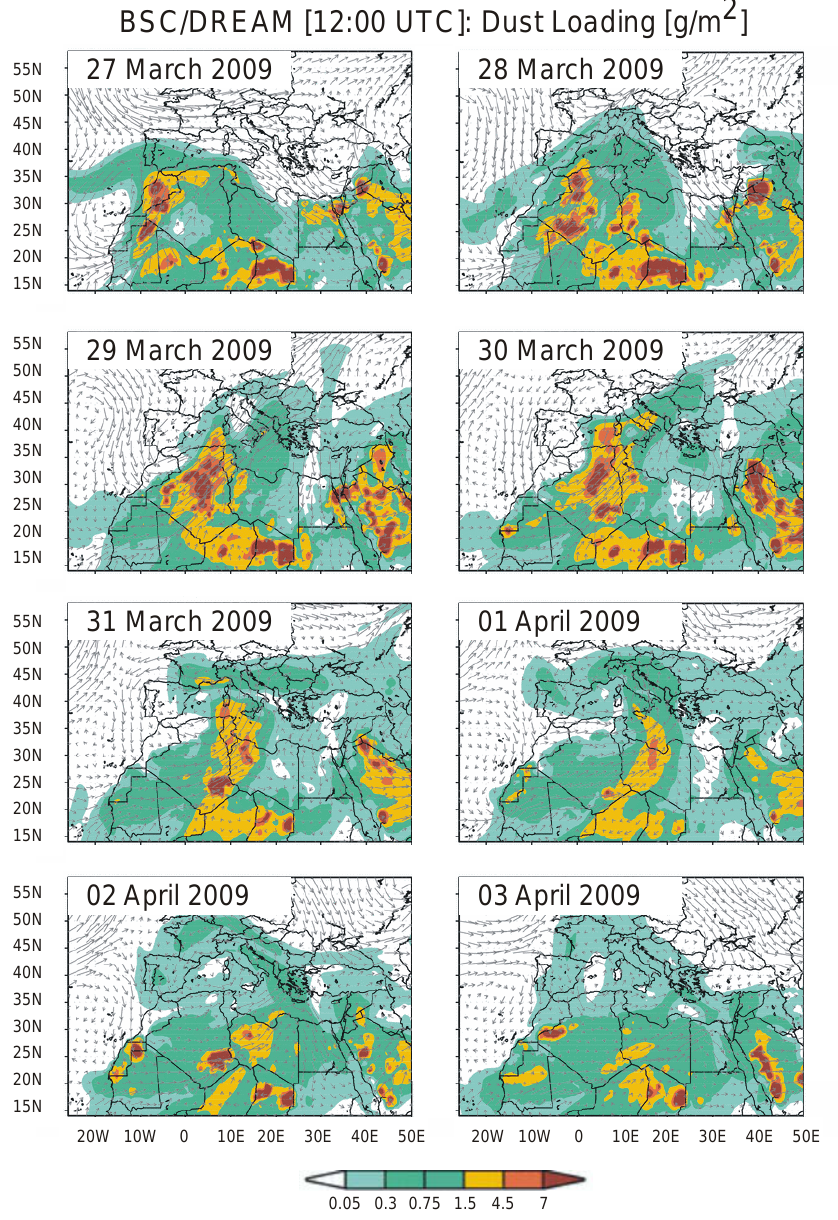
Fig. 1. Dust loading (in gm − 2 ) over Europe in the period between 27 March and 3 April 2009, as estimated by the BSC-DREAM forecast model (12:00UTC). The wind field pattern is also shown for 3000m height level.